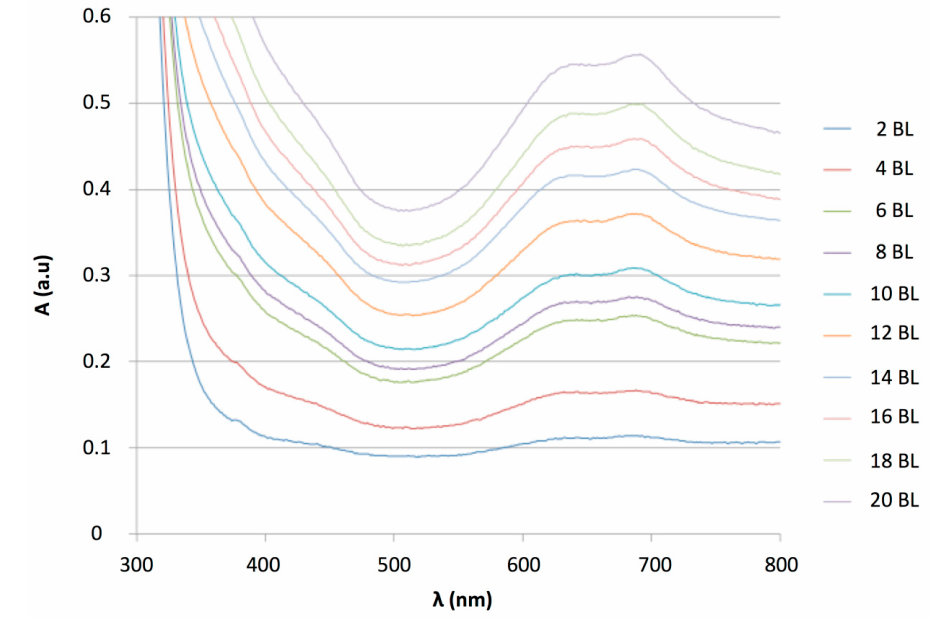
Figure 8. (PANI/CuTsPc) BL